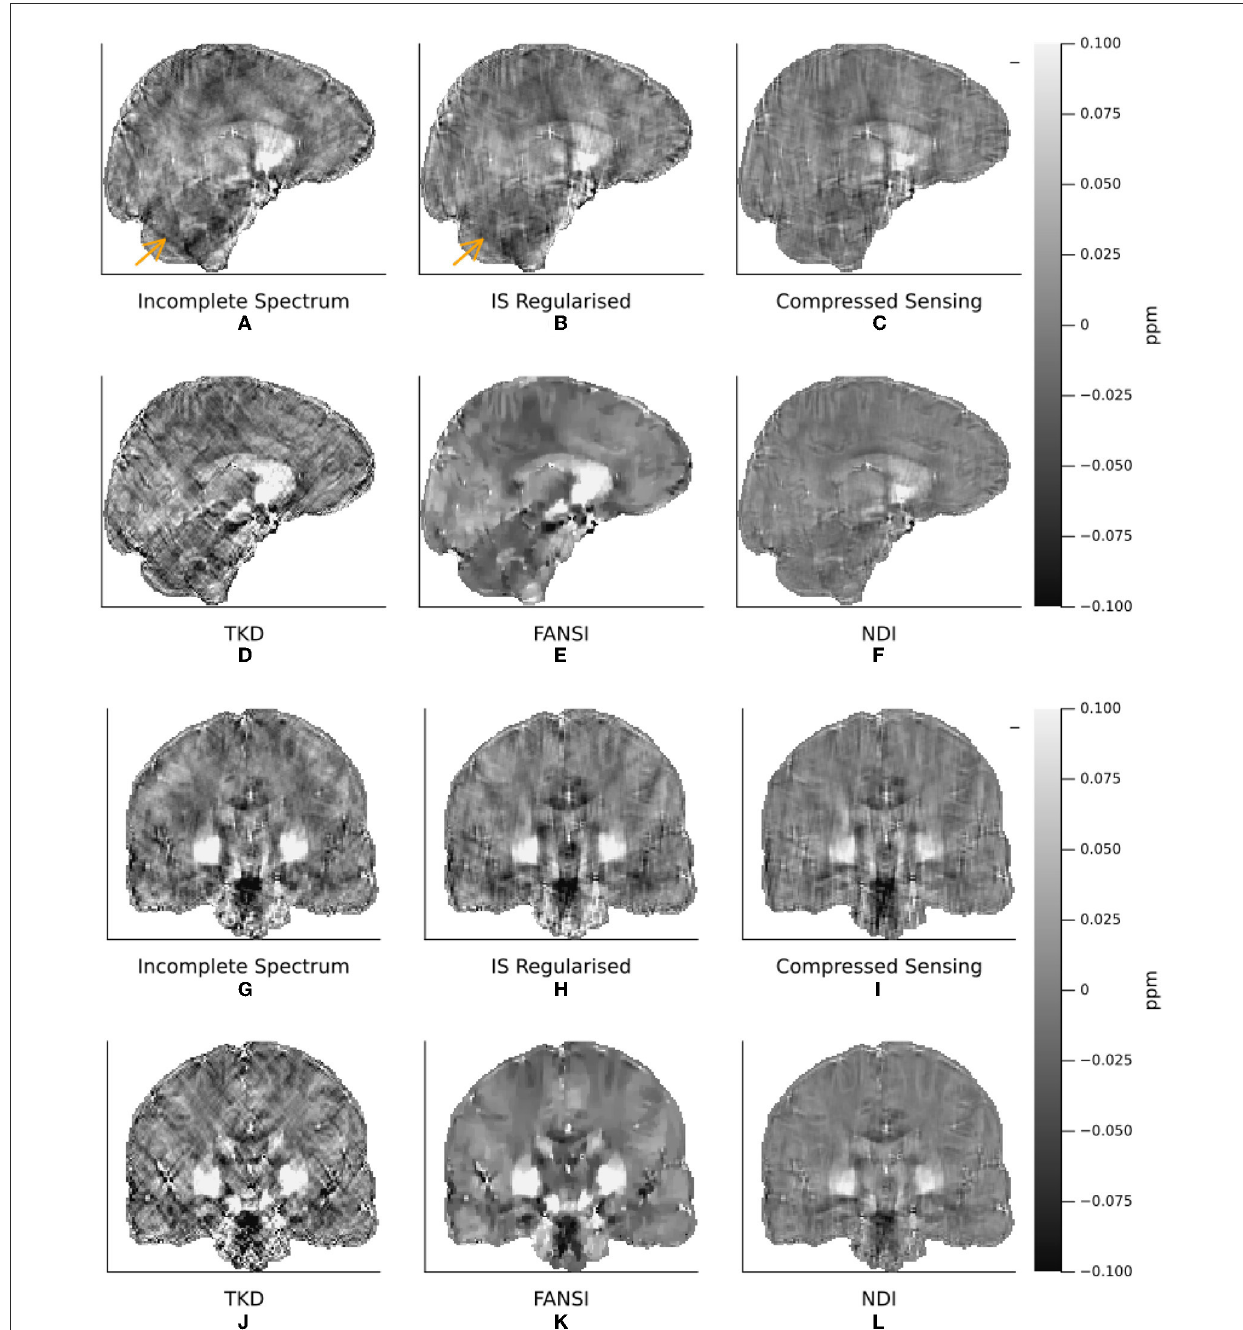
FIGURE7 A Comparison of Incomplete Spectrum QSM with Conventional QSM Reconstruction Methods in a representative healthy volunteer. Coronal (A–F) and sagittal (G–L) and slices are shown to highlight streaking artifacts. The incomplete spectrum reconstruction (A, G) used the XSIM-optimal regularization weight determined from the challenge dataset, ( t well = 0.25). PSNR/XSIM optimal regularization parameters for the other QSM methods are given in Table 1. The reconstructions are ordered as incomplete spectrum (A, G) , regularized incomplete spectrum (B, H) , compressed sensing (C, I) (top row). Followed by TKD (D, J) , FANSI (E, K) , and NDI (F, L) . The orange arrow highlights a streaking artifact that is reduced by the added regularization in the regularized incomplete spectrum reconstruction (B)